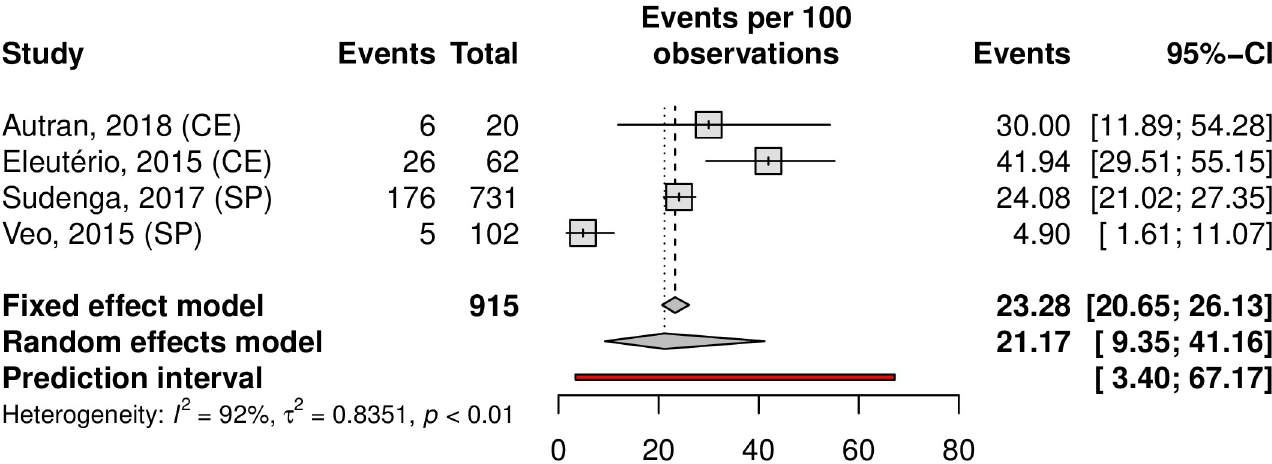
Fig 18. Prevalence of anal HPV infection in low-risk populations. Forest plot of a metanalysis of studies reporting prevalence of anal infection by HPV in low- risk populations in Brazil.